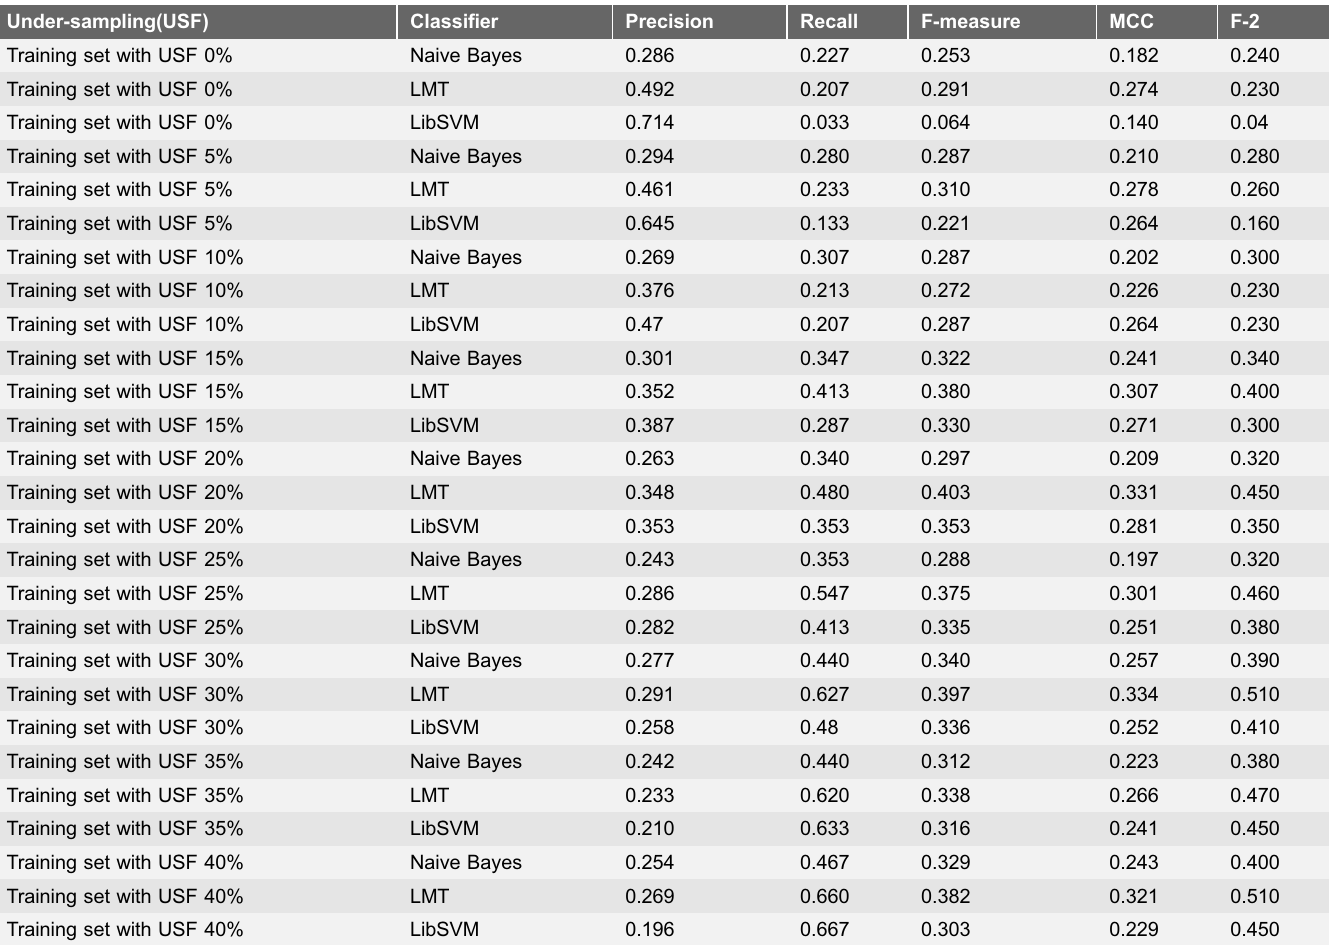
Table 5. mycoSORT Results - Set of Features